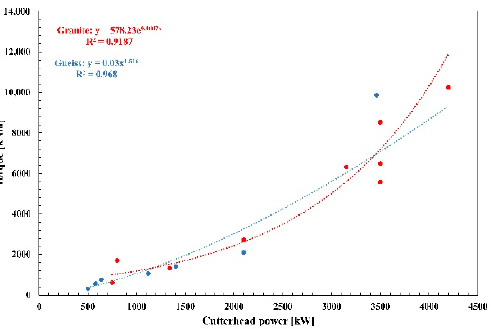
Figure 11. Correlation between the power and the torque due to the excavation in granites and gneisses by open TBMs.